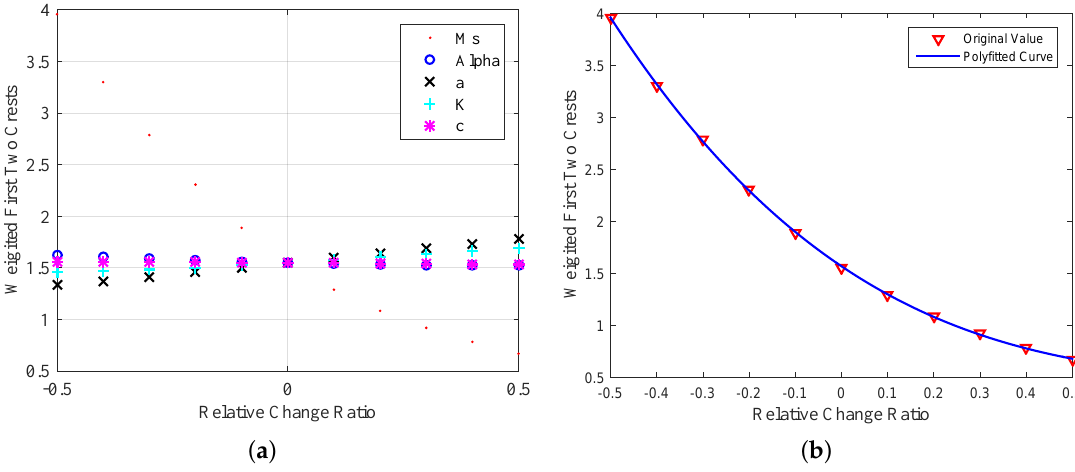
Figure 7. Impact of the J–A parameters on the weighted crests ( a ); and the polyfitted curve for M s ( b